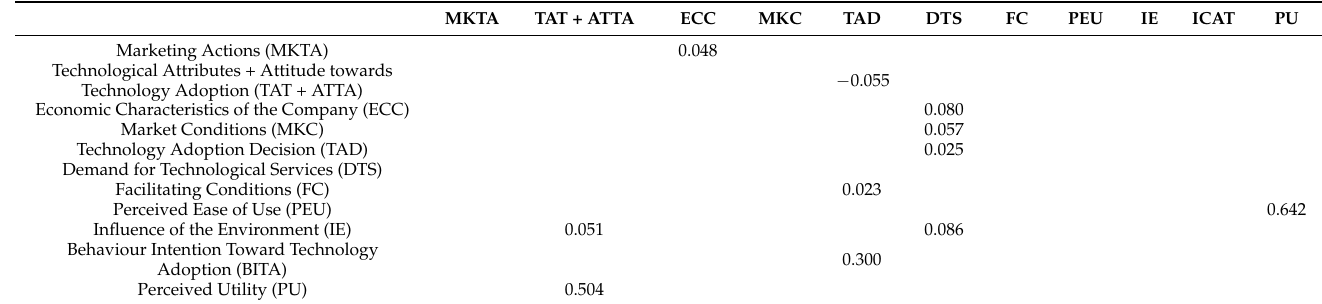
Table 15. q 2 Effect